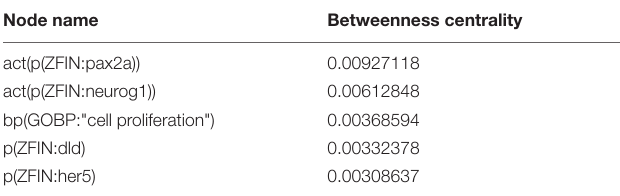
TABLE 1 | Nodes with the highest number of total edges. TABLE 2 | Nodes with the highest betweenness centrality.